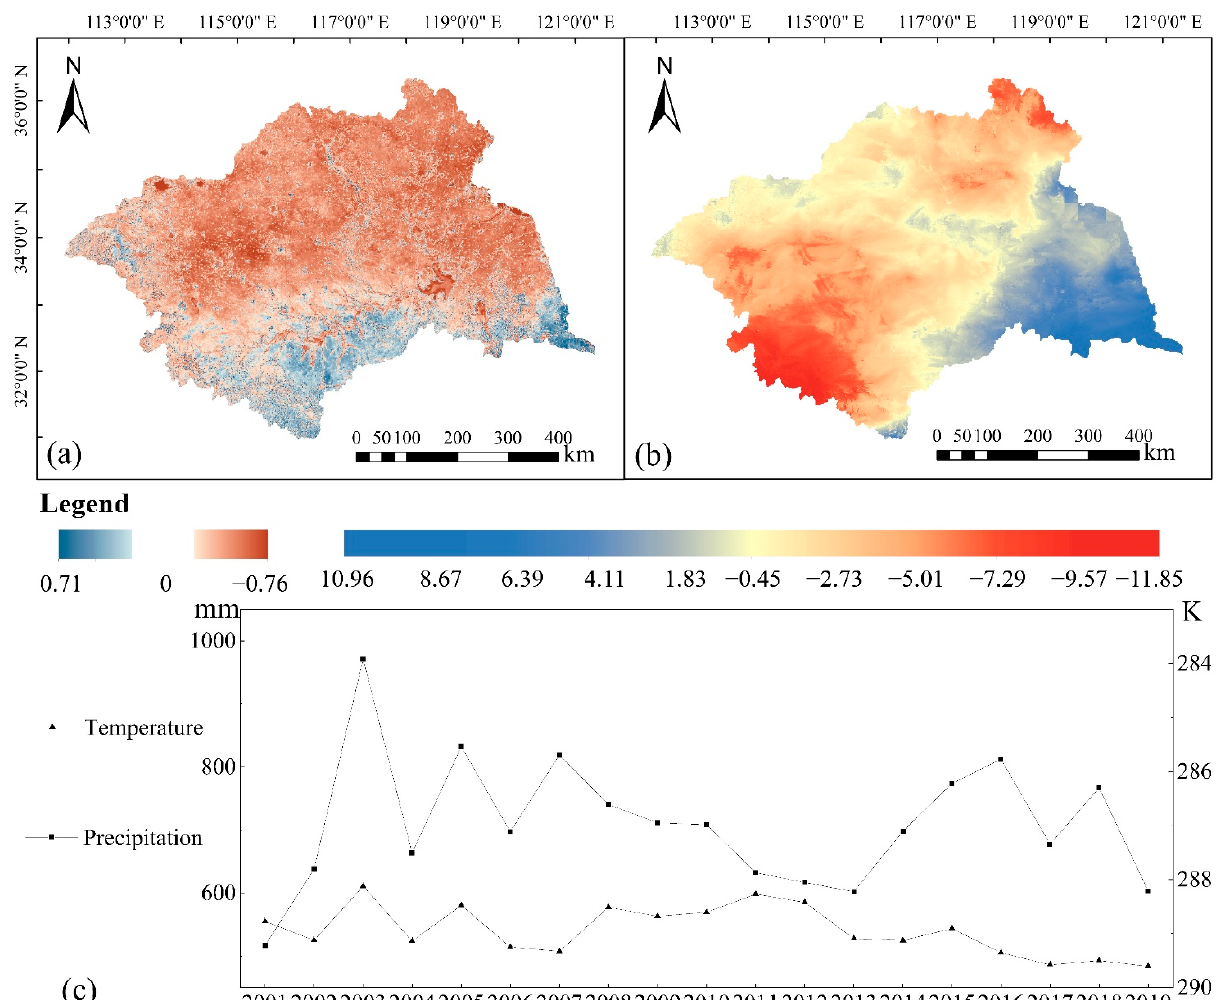
Figure 7. ( a ) Spatial distribution map indicating the correlation coefficient between the ES level and the average annual precipitation for each grid. Negative values represent negative correlations, while positive values represent positive correlations; a higher absolute value indicates a stronger correlation. ( b ) Change trends of precipitation in the HRB. Positive values indicate an increasing trend, while negative values indicate a decreasing trend; a lower absolute value indicates a smaller change in precipitation. ( c ) Average annual precipitation and temperature in the HRB from 2001 to 2019.